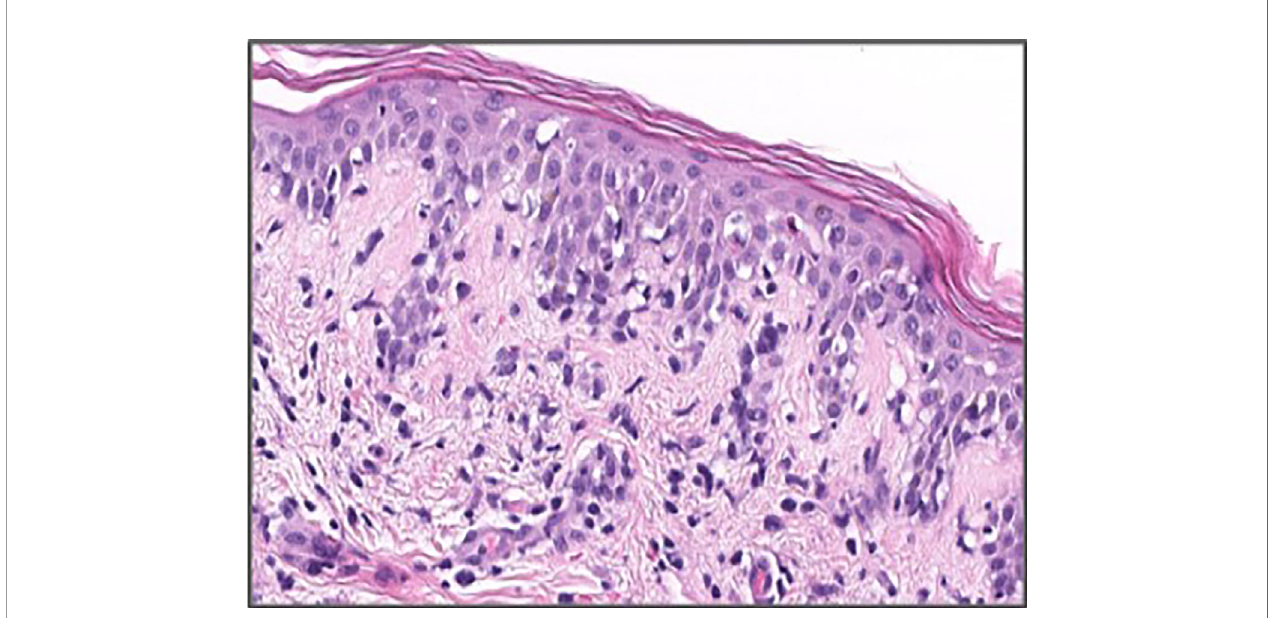
FIGURE 2 | H and E stain of right lower abdomen punch biopsy showing focal epidermal dyskeratosis, mild spongiosis, and moderate vacuolar interface dermatitis in association with super fi cial perivascular lymphohistocytic in fl